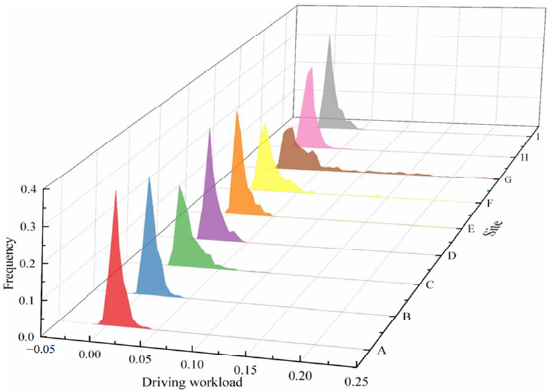
Figure 7. Frequency distribution of driving workload in different areas.